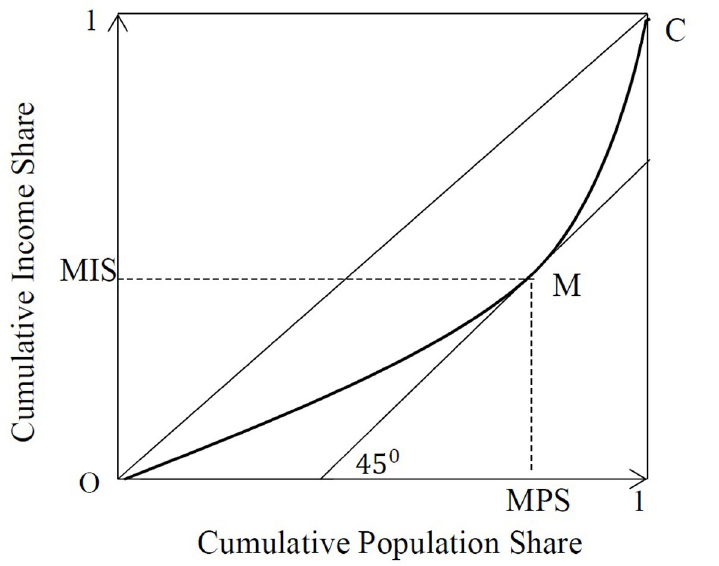
Fig 1. Illustration of MPS and MIS on the